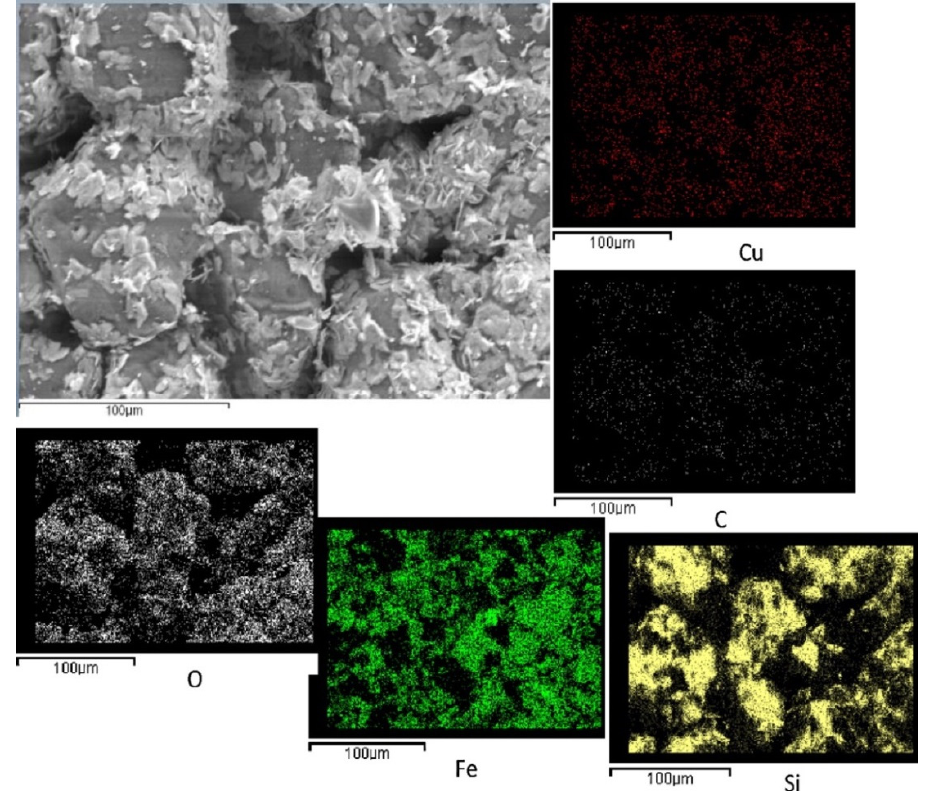
Figure 4. External surface of a channel of a 15% wt CuFe 2 O 4 catalyzed DPF: SEM image and EDX maps of the corresponding area for copper (Cu), carbon (C), silicon (Si), iron (Fe), and oxygen (O). From [28].